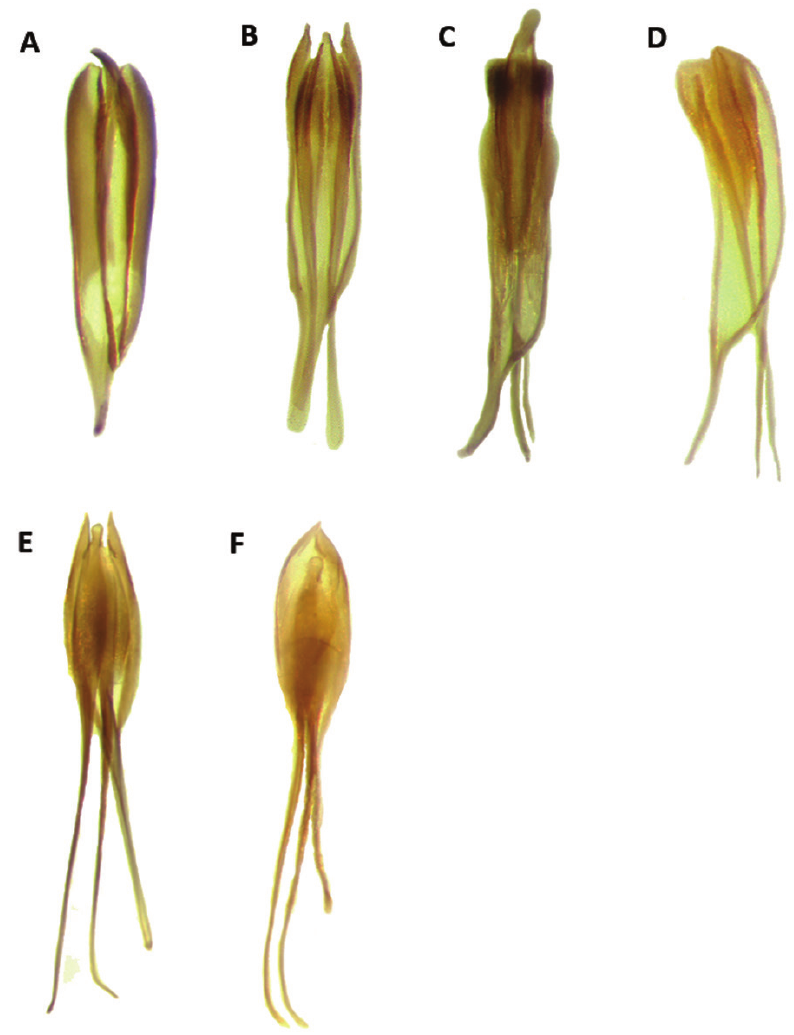
Figure 19. Male genitalia of: A Neocallotillus elegans ( vafer ) B Cymatoderella collaris C Cymatoderella morula D Cymatoderella patagoniae E Lecontella brunnea F Lecontella gnara .